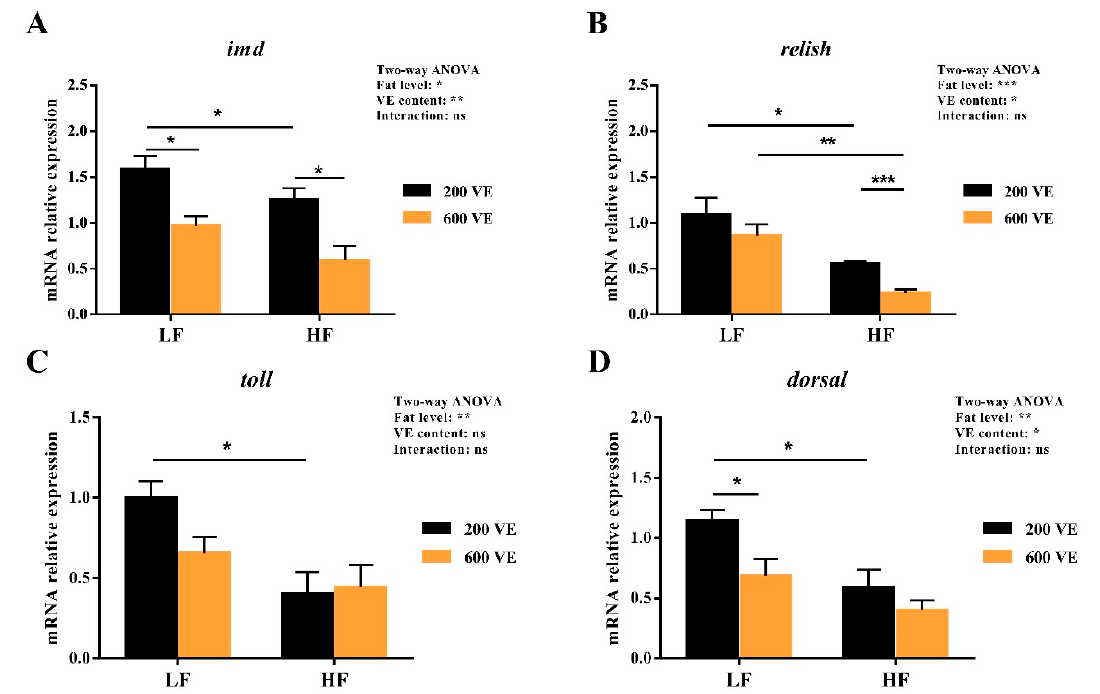
Figure 7. Relative expression of NF- κ B signal pathway in hepatopancreas. ( A ) relative expression of imd in hepatopancreas; ( B ) relative expression of relish in hepatopancreas; ( C ) relative expression of toll in hepatopancreas; ( D ) relative expression of dorsal in hepatopancreas. Values are means ± SEM. ***: p < 0.001, **: p < 0.01, *: p < 0.05, ns: p < 0.05.